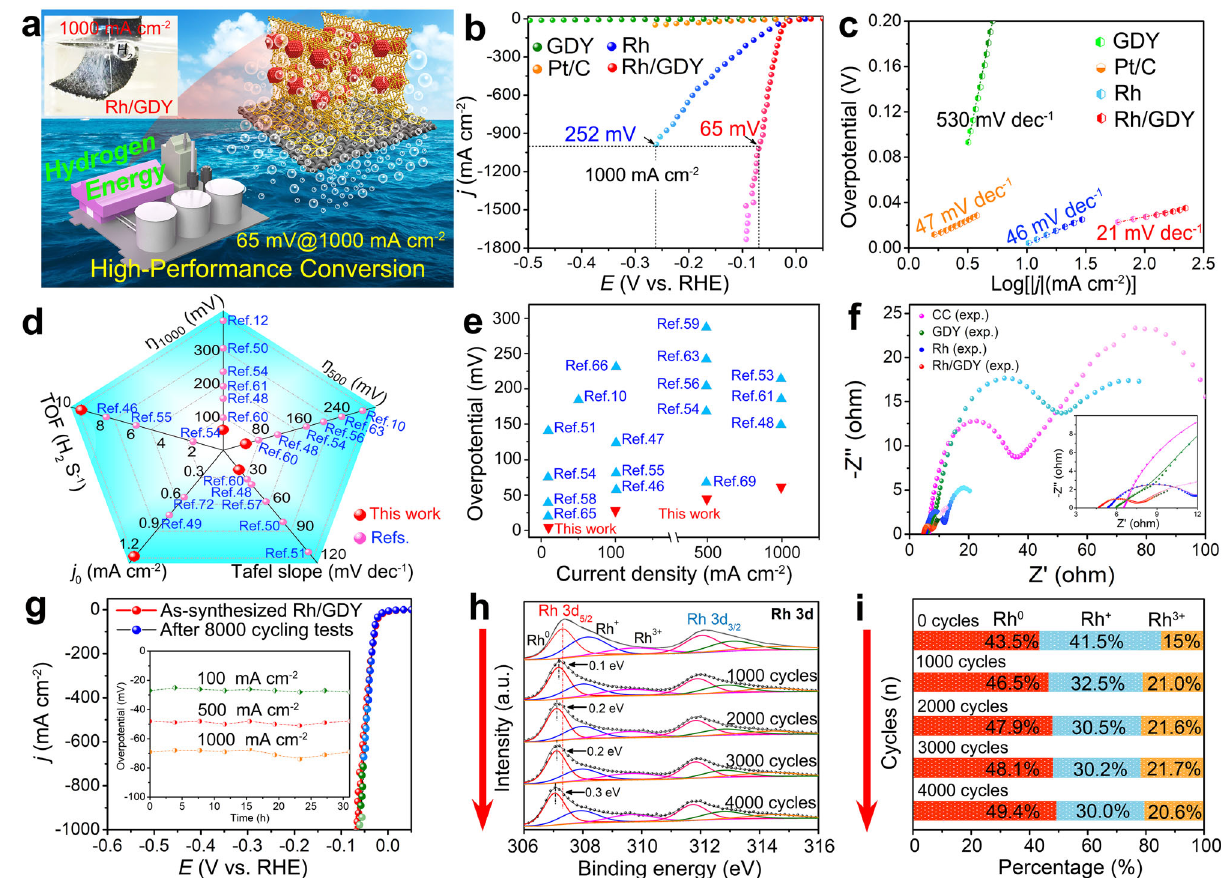
Fig.4|HERperformancesofRh/GDYinsalinewater.a Schematicrepresentation of ef fi cient hydrogen fuel production on Rh/GDY. Inset: photograph of the hydrogen evolution on Rh/GDY electrode at 1000mAcm − 2 . b HER polarization curves and c corresponding Tafel plots of the as-synthesized catalysts. d , e Comparison of the HER catalytic activity of the Rh/GDY with the reported